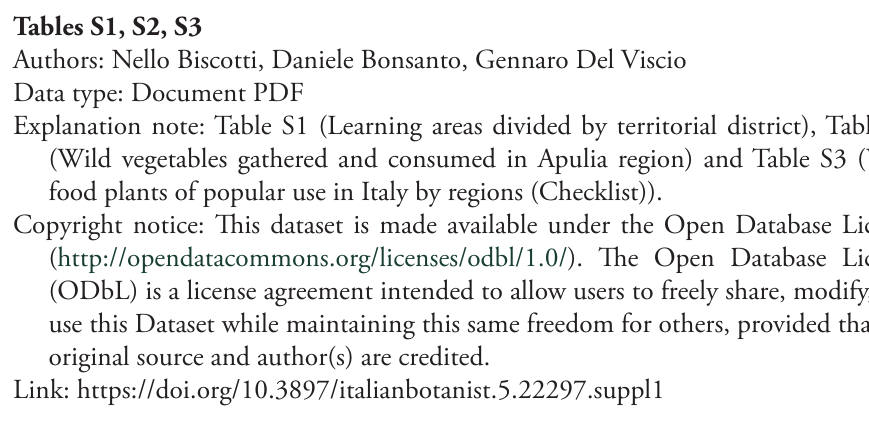
Explanation note: Table S1 (Learning areas divided by territorial district), Table S2 (Wild vegetables gathered and consumed in Apulia region) and Table S3 (Wild food plants of popular use in Italy by regions